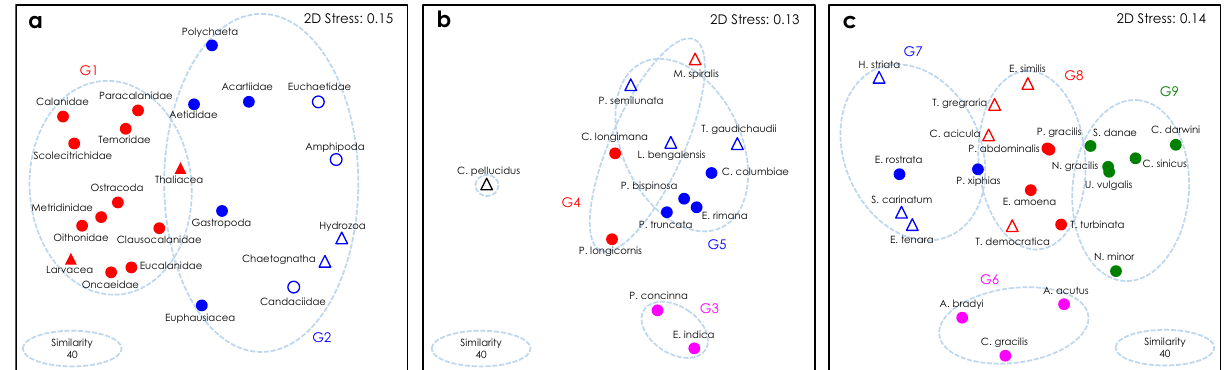
Figure 4. Non-metric multi-dimensional scaling (NMDS) ordination plot of the standardized sequence reads of ten dominant prey OTUs in gut-content DNA of mesozooplankton groups ( a ), carnivorous species ( b ) and omnivorous species ( c ) based on Bray–Curtis similarity. Groups within broken lines (G1 to G9) show clusters classified on the bases of similarity of prey proportions. Symbols with the same colors belong in same cluster. ( a ) Omnivorous (solid symbols) and carnivorous (open symbols) groups. ( b , c) Calanoids (circles) and other (triangles) groups.